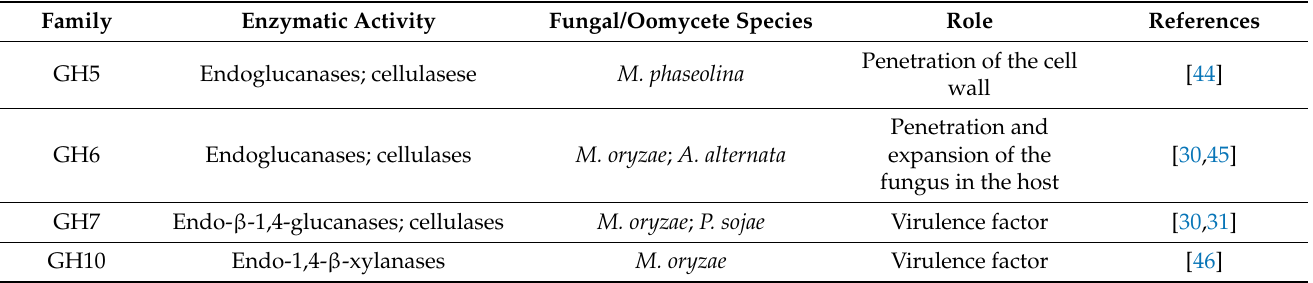
Table 1. Known glycoside hydrolase families in phytopathogenic fungi and oomycetes and their potential function. Family Enzymatic Activity Fungal/Oomycete Species